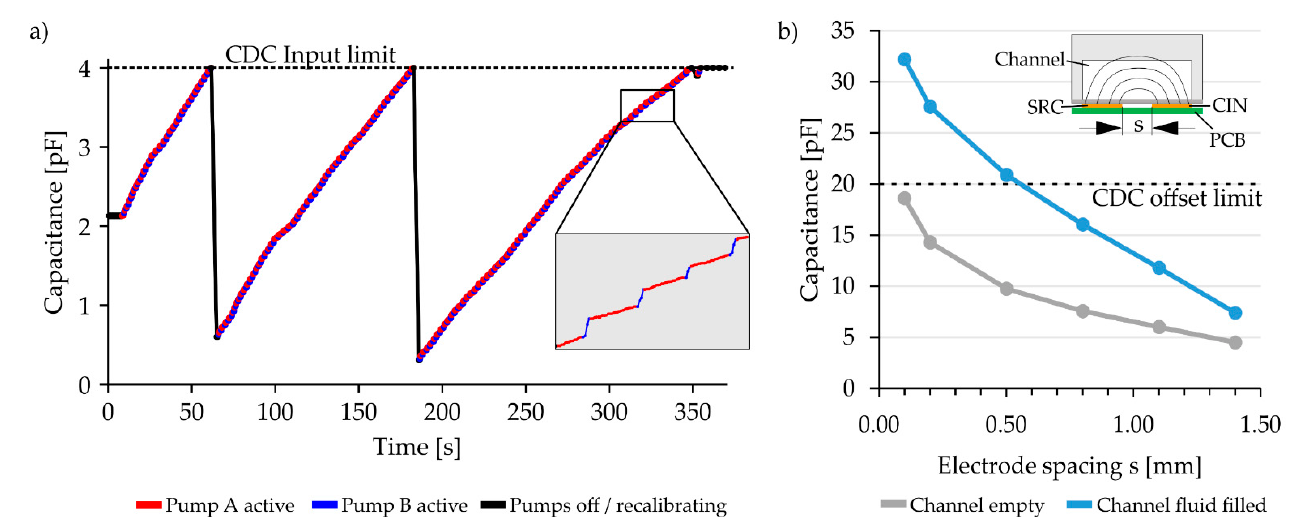
Figure 4. ( a ) Capacitance data measured by the “meander” electrode. The capacitance rises as fluid is pumped into the meander channel. The capacitance induced by each pump is used to determine when to switch the pumps. The insert shows exemplary data in more detail. The “blue” pump has a higher flow rate; therefore, the capacitance rises quicker when the blue pump is active. Recalibration steps are performed just before the meander capacitance reaches a value of 4 pF (=2 16 counts). The recalibration moves the active sensor range by internally subtracting a capacitance offset and moving the measured capacitance back towards the bottom of the ±2 pF sensor range, thus increasing the high-resolution sensing range of the system. ( b ) Simulation data showing the capacitance of empty and full meander channels for variations in the electrode spacing s between the excitation electrode (SRC) and the measurement electrode (CIN). If 𝑠 is smaller than 0.6 mm, then the capacitance of the associated meander electrode exceeds the CDC capacitance offset limit (dotted line) and hence the sensor range when the channel is filled with fluid. For the final system, an electrode spacing of s = 0.8 mm was chosen.